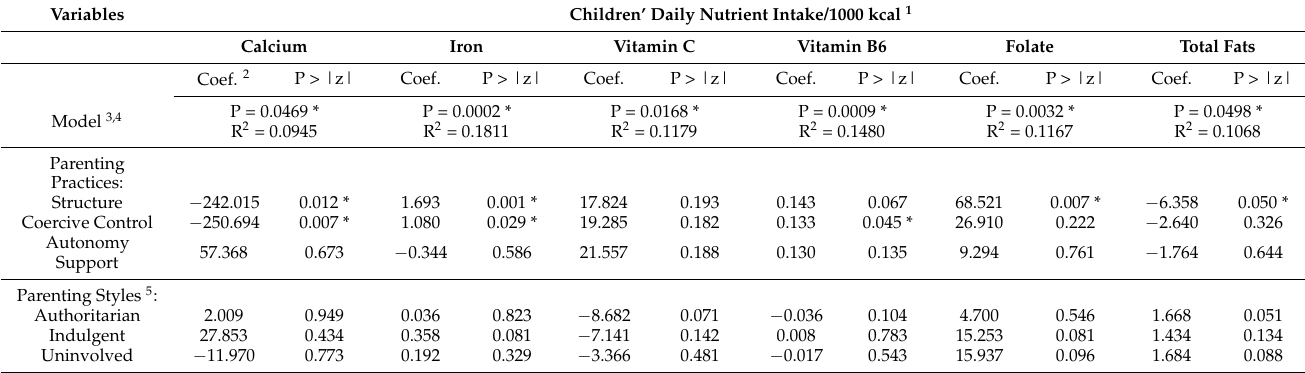
Table 5. Adjusted regression models for children’s daily nutrient